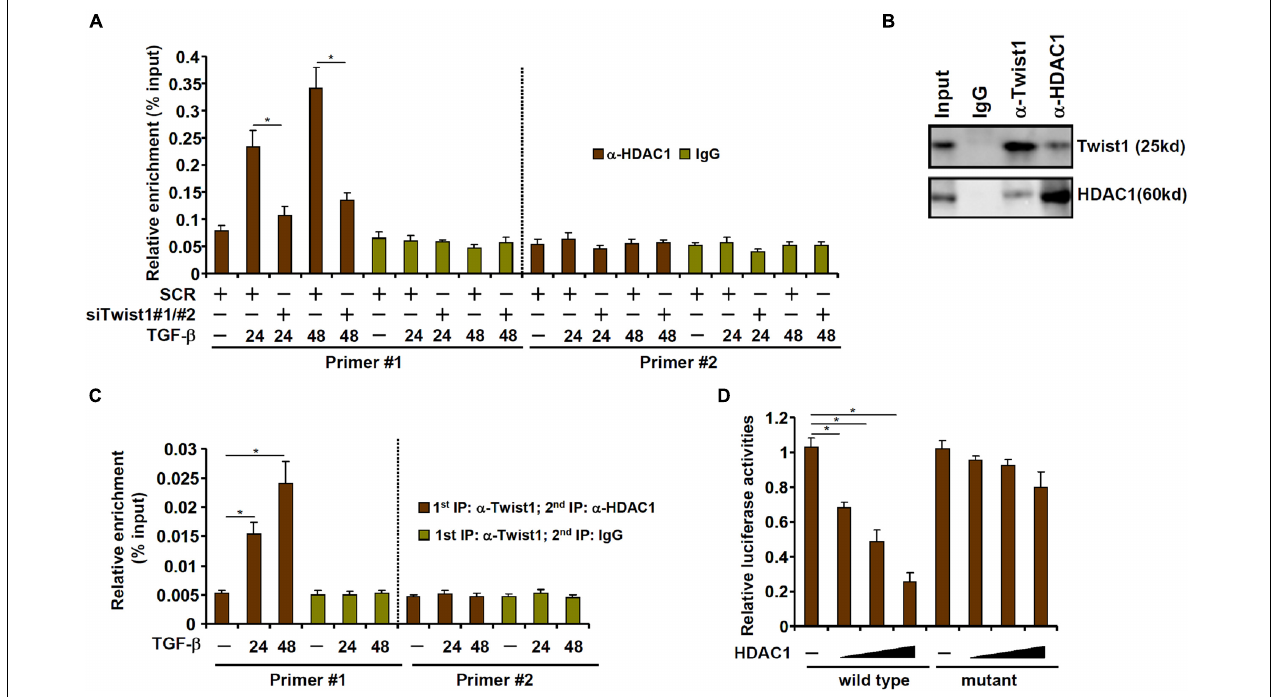
FIGURE 4 | TWIST1 interacts with and recruits HDAC1 to repress Clca2 transcription. (A) Primary cardiac murine fibroblasts were transfected with indicated siRNAs by treatment with TGF- β (2 ng/ml). ChIP assays were performed with indicated antibodies. (B) Immunoprecipitation was performed with whole cell lysates from primary murine cardiac fibroblasts. (C) Primary murine cardiac fibroblasts were treated with or without TGF- β (2 ng/ml) for 48 h. Re-ChIP was performed with indicated antibodies. (D) Wild type and mutant Clca2 promoter-luciferase constructs were transfected into MEFs with increasing doses of HDAC1 followed by treatment with TGF- β . Luciferase activities were normalized by protein concentration and GFP fluorescence. Error bars represent SD (* p < 0.05, two-way Student’s t -test). All experiments were repeated three times and one representative experiment is shown.